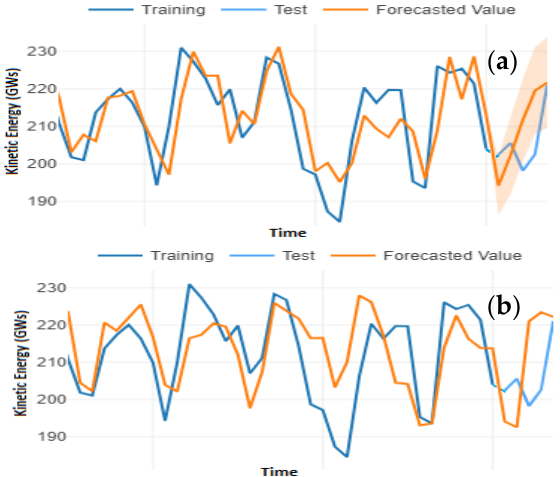
Figure 8. Zoomed window for the last five hours ( a ) for the Bayesian and ( b ) ARIMA models.